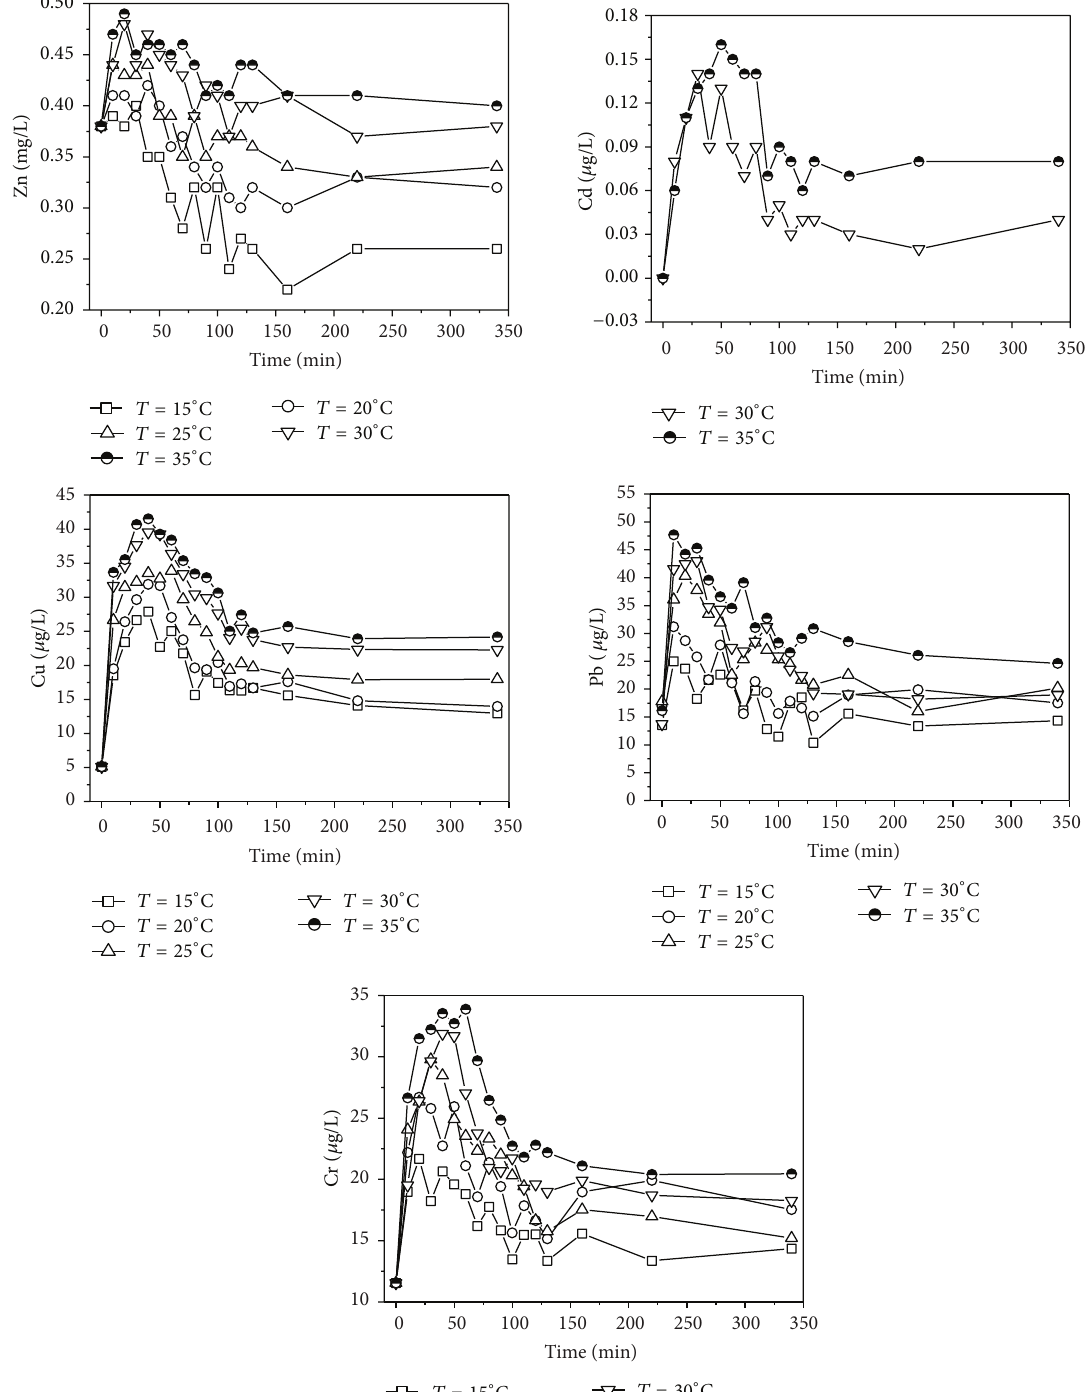
Figure 6: The concentration of Zn, Cd, Cu, Pb, and Cr from sediments changed with